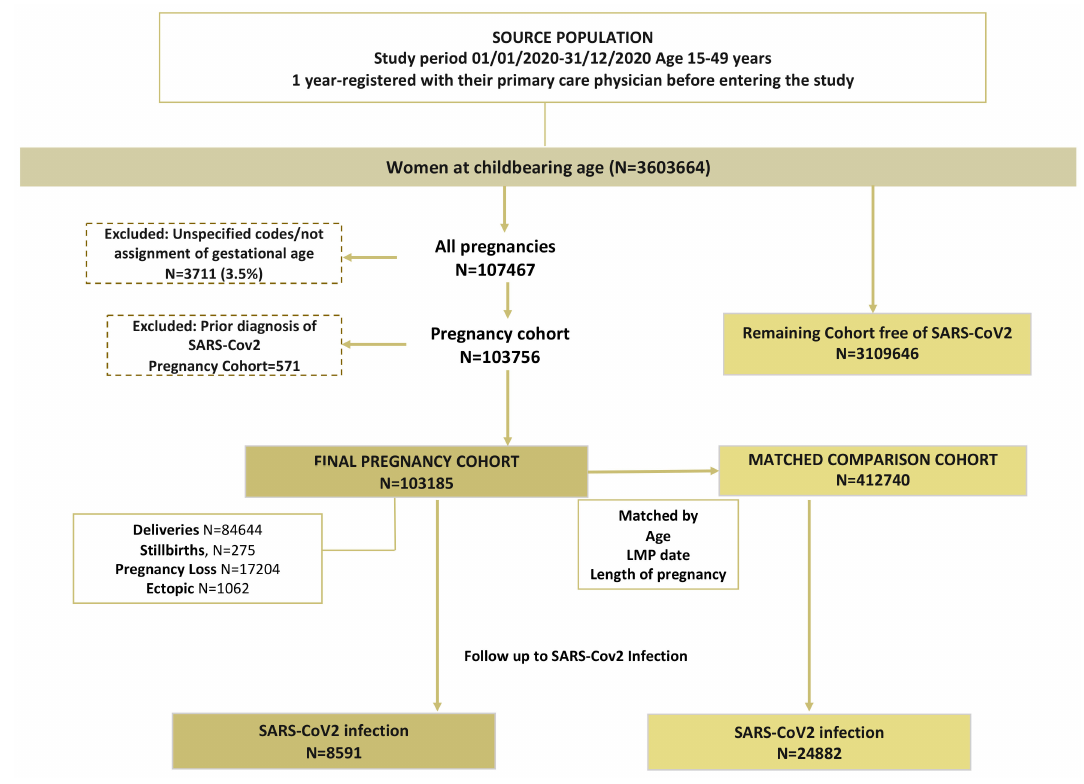
Figure 1. Flow chart of the study